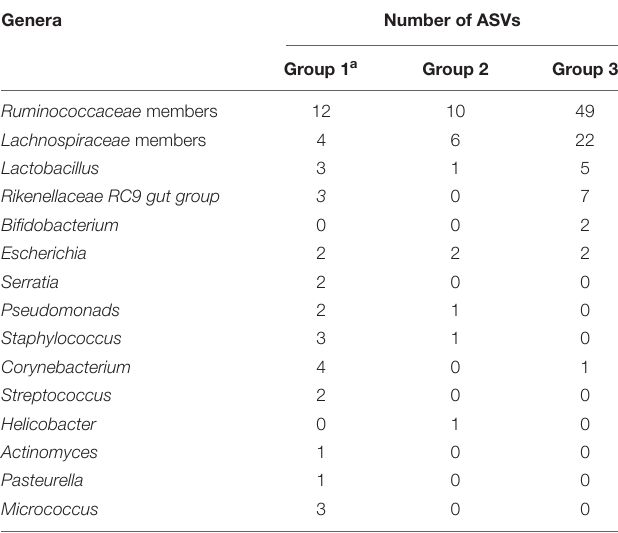
bacteria can be explained by the lack of representation of certain animal gastrointestinal tract microbiota in 16S rRNA gene databases (Stewart et al., 2019). Probiotics with Lactobacillus are